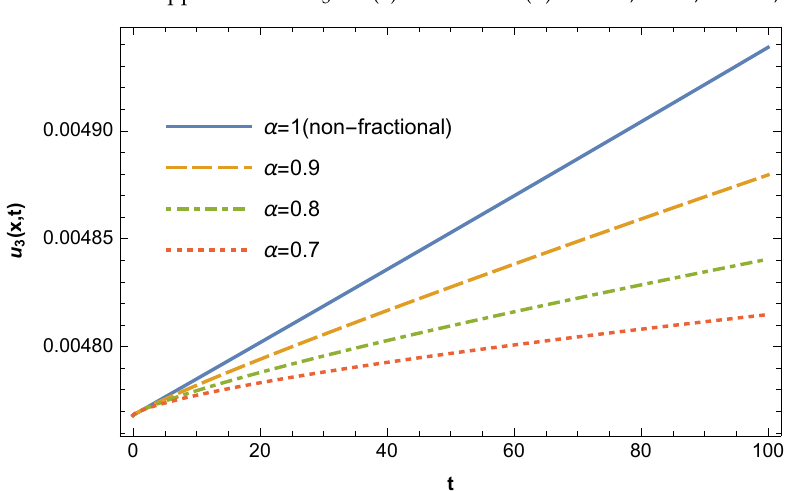
Figure 3. The FRDTM approximate solutions u 3 ( x , t ) for α = 1,0.9,0.8,0.7; t ∈ [ 0,100 ] , and x =